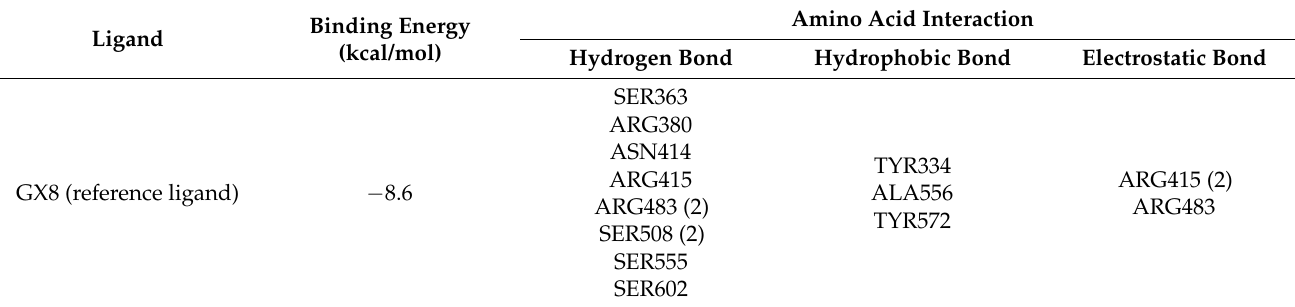
Table 2. Molecular docking results of candidate ligands at the binding site of KEAP1 (PDB ID: